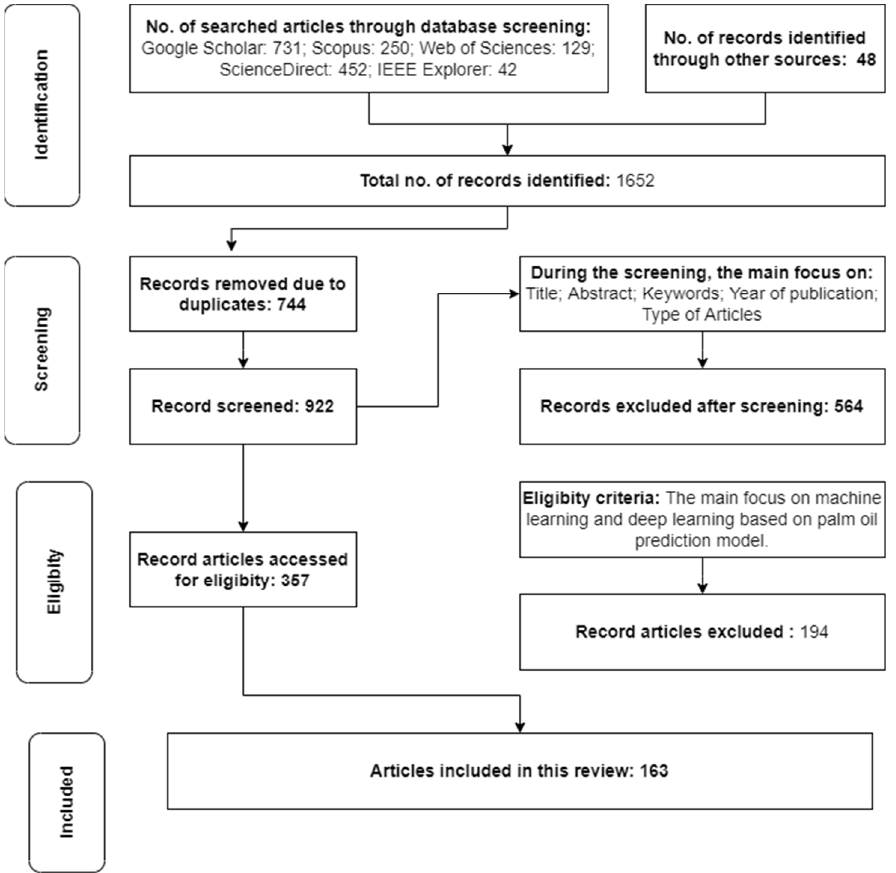
Figure 1. The PRISMA flow diagram.